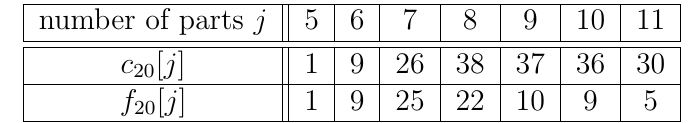
Table 9: Number of potentially (row c partitions of 20 with given number of parts j .